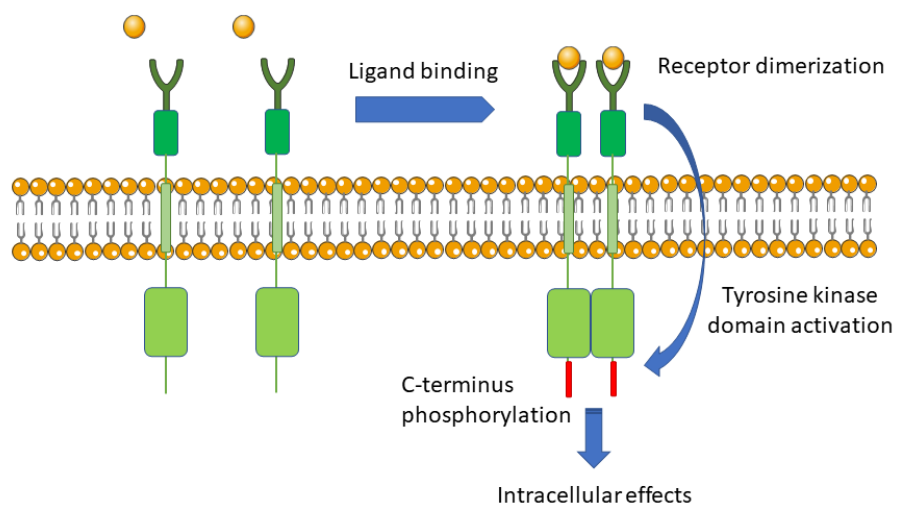
Figure 2. The schematic mechanism of signal transduction via the membrane receptor [141]. Based on the number and nature of transmembrane domains, three classes of membrane receptors are distinguished [141]. Class I contains receptors comprised of several protein subunits, each repeatedly pierces the cell membrane, that together form an ion channel, such as ionotropic receptors (IRs) [142]. Class II consists of receptors composed of one peptide chain, which penetrates the cell membrane several times; for example, G protein-coupled receptor (GPCR) penetrates the membrane seven times [143]. Class III includes receptors that penetrate the cell membrane once. The latter may have a monomeric (receptors of most growth factors) or oligomeric structure (insulin and most cytokine receptors). Class III receptors have the amino acid sequence with enzymatic activity (e.g., non-receptor tyrosine kinases [144] or contain the so-called death domain (DD) [145] (Figure 3)).